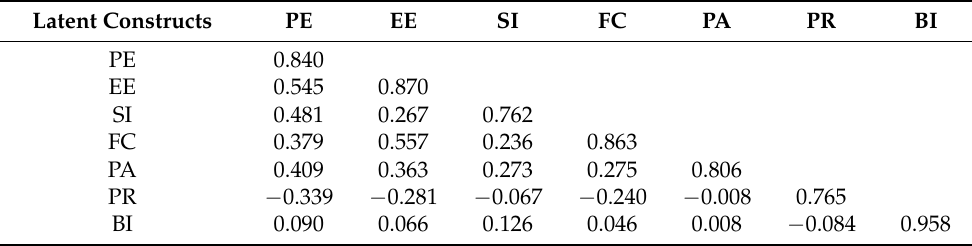
Table 4. Discriminant validity.